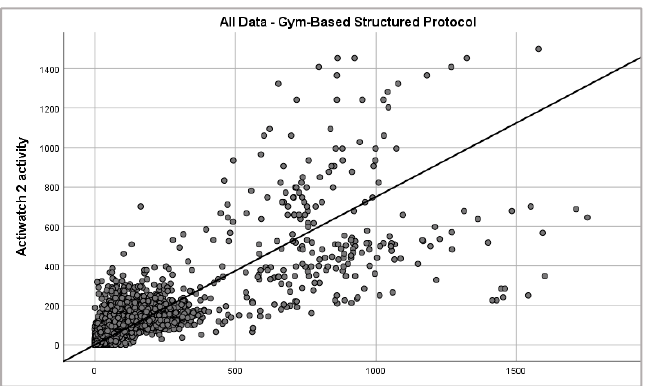
Figure 5. Epoch-by-epoch absolute activity of Actiwatch 2 and Verisense as recorded from all subjects over gym-based supervised protocol (2330 data points).